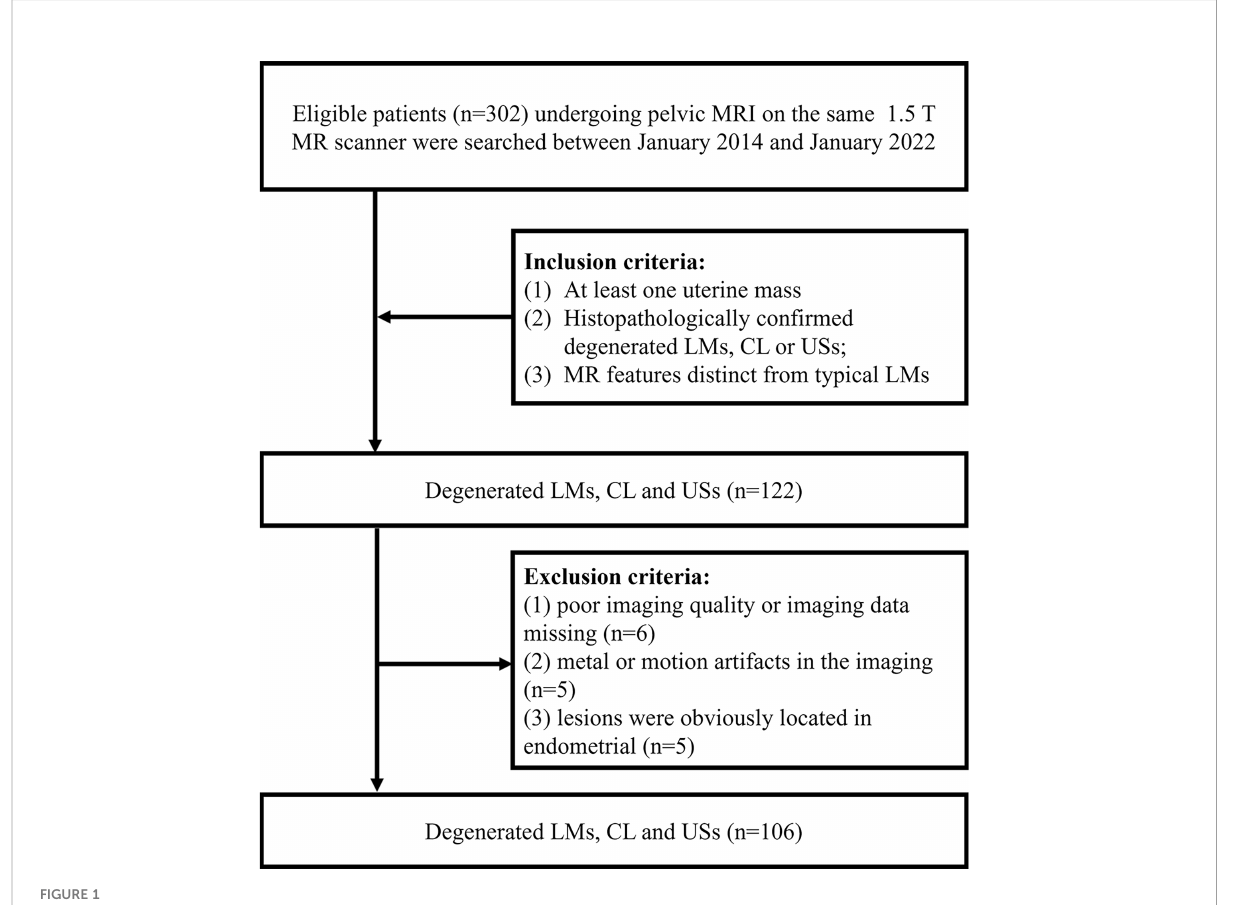
FIGURE 1 Flowchart showing the patient enrollment